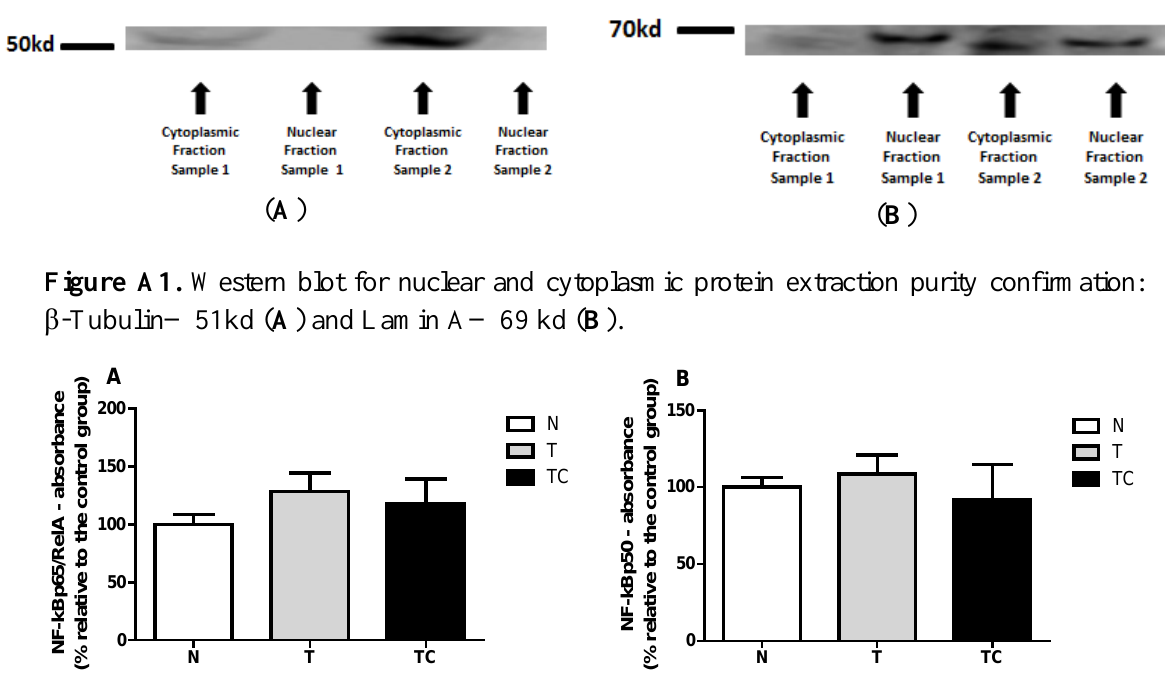
Figure A2. NF-κBp65 binding to the DNA NF-κB promoter region ( A ) and NF-κBp50 binding to the DNA NF-κB promoter region ( B